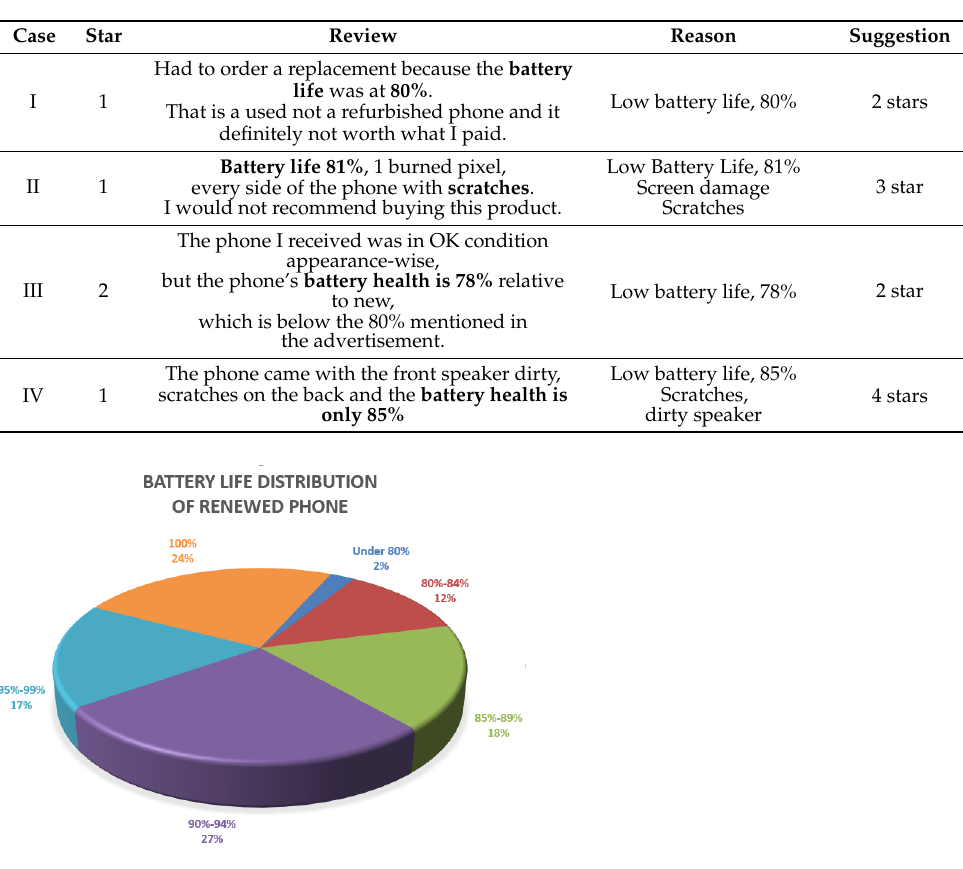
Figure A7. Customer review case of a renewed iPhone X. Table A5. Customer review cases of a renewed iPhone.